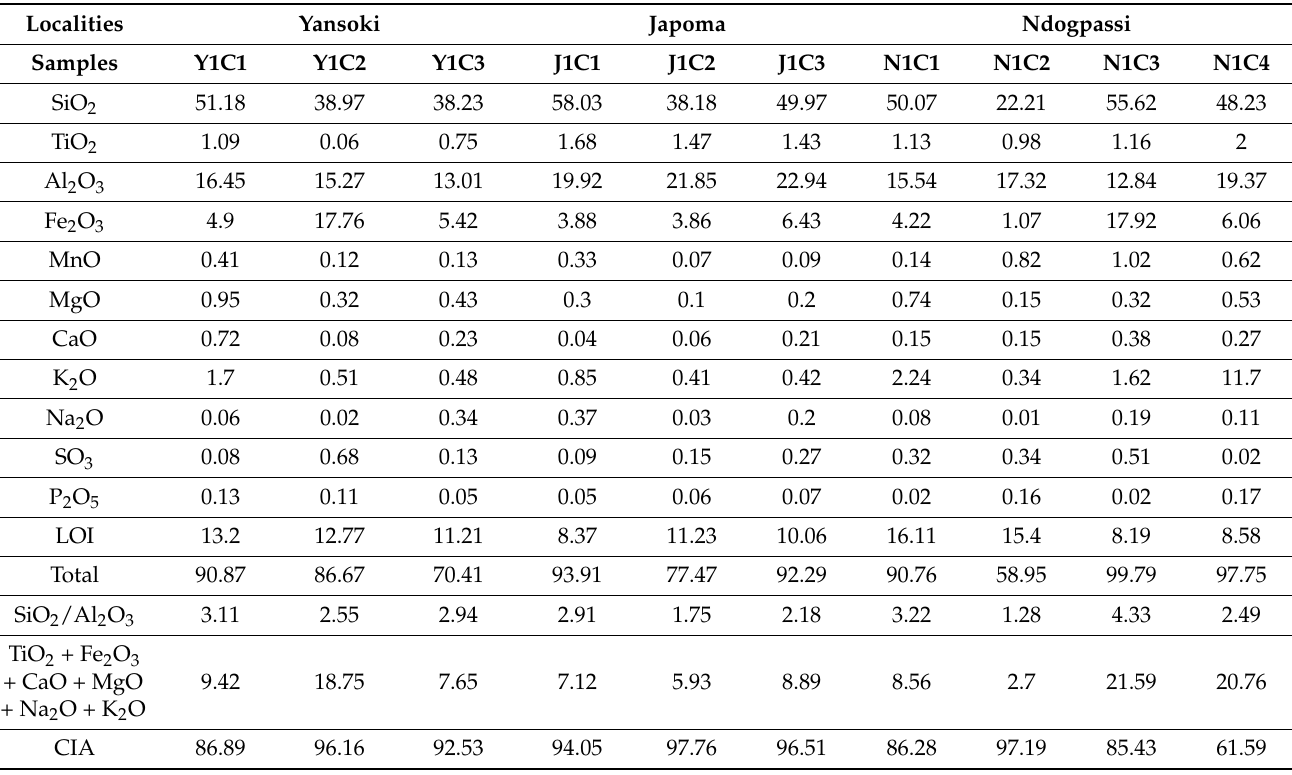
Table 2. Geochemical composition (wt.%) of clay materials of the eastern part of the Douala sub-basin determined by XRF.